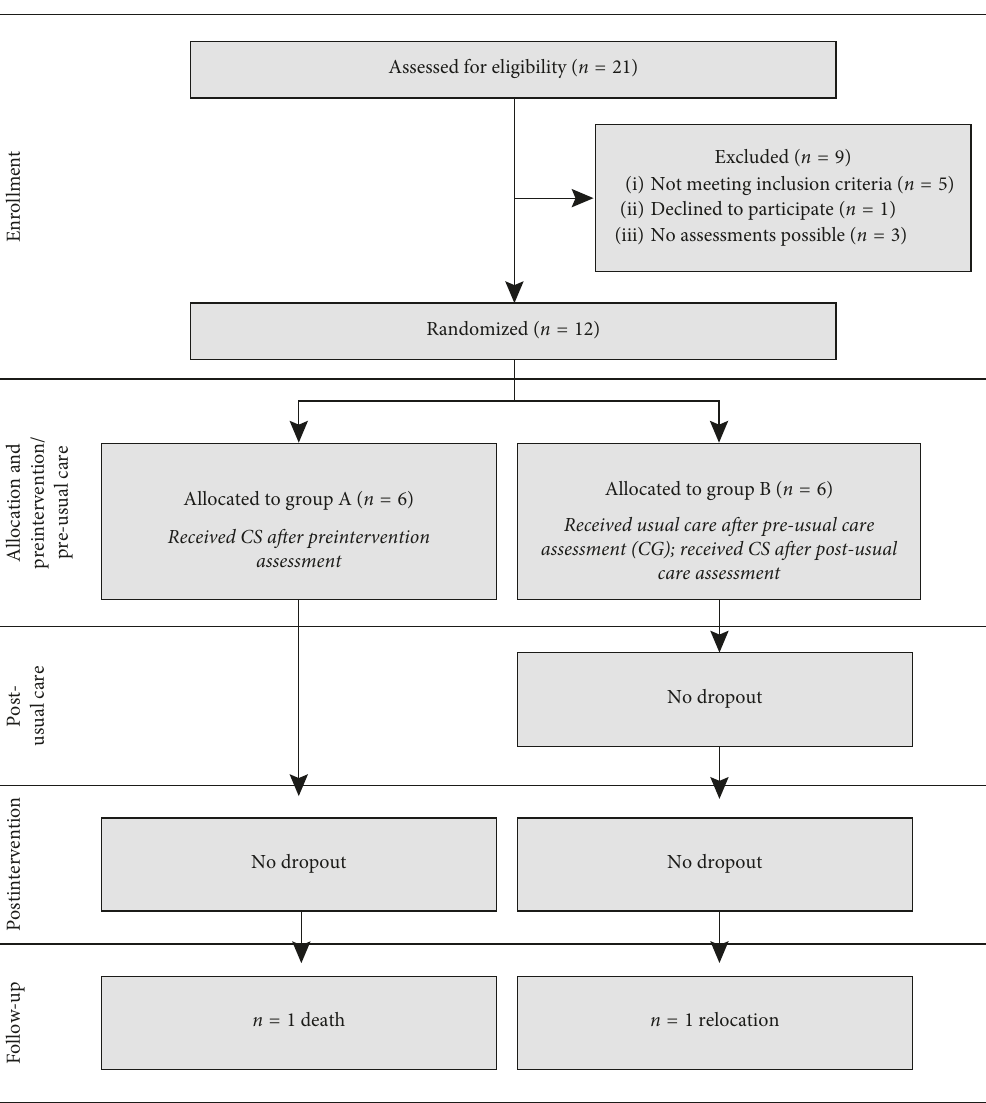
Figure 2: Flowchart of the participants recruited for this